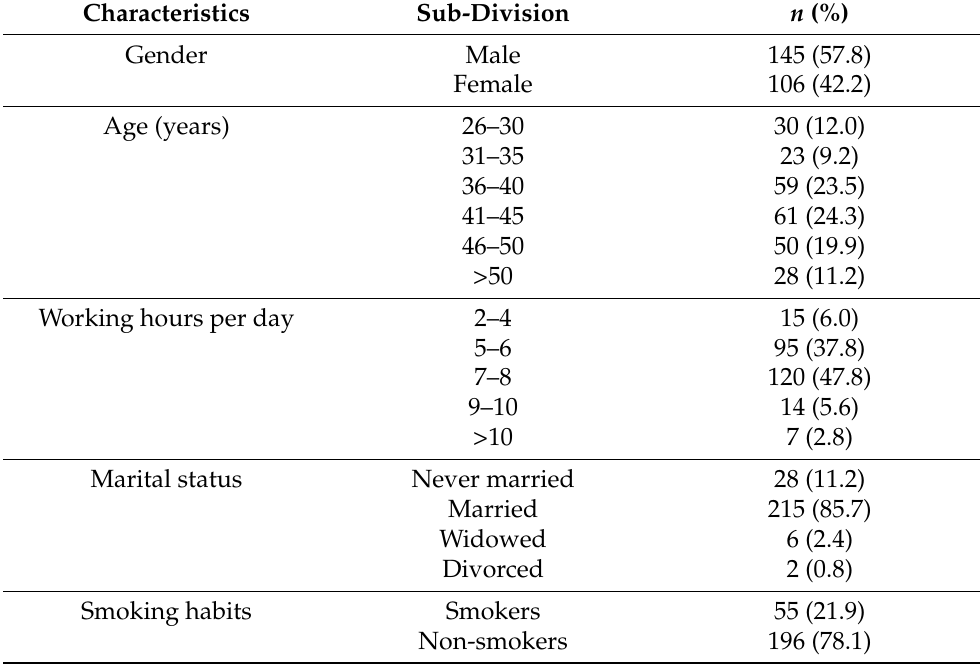
Table 1. Demographics, lifestyle and work characteristics of the participants ( n =